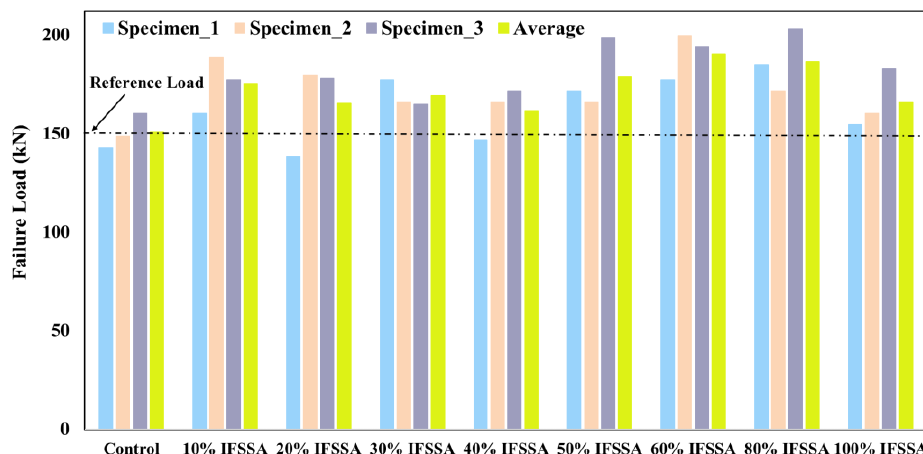
Figure 6. Failure load of RC beams made with different percentages of IFSSA.